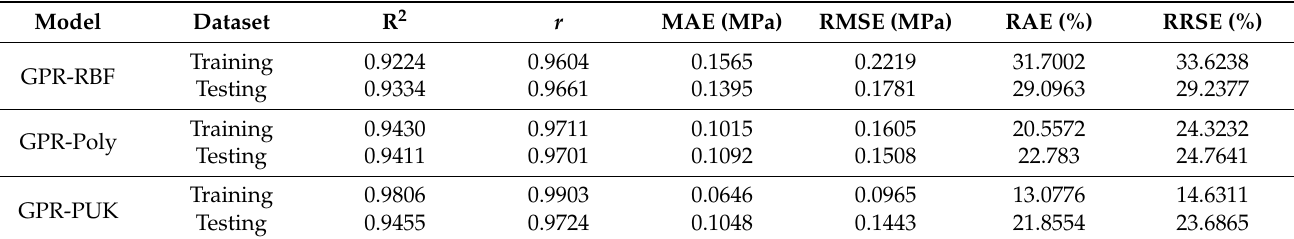
Table 5. Statistical indices and error measures between experimental/actual and predicted shear strength of three different models used in present study for